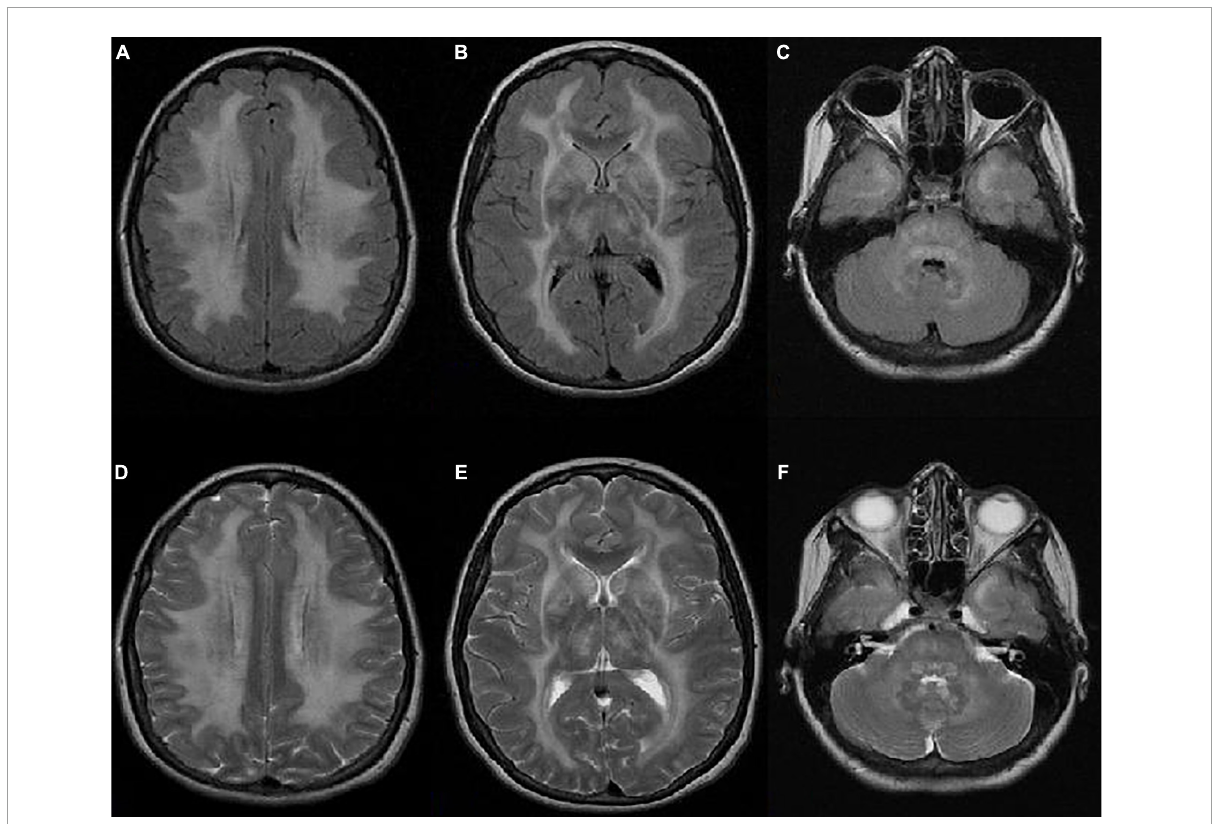
FIGURE1 Axial FLAIR (A–C) and T2-weighted (D–F) MR images showing bilateral hyperintensities and edema in the basal ganglia. Diffuse leukoencephalopathy is visible with hyperintensities of the periventricular, subcortical, and deep white matter, including the pons and white matter of the cerebellum. There is no pathological imbibition of contrast or diffusion